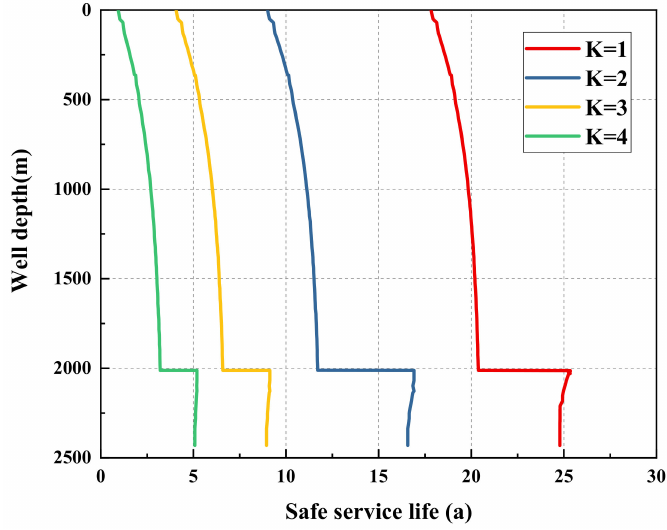
Figure 16. Influence of the stress concentration coefficient on the corrosion life of the outer layer of the